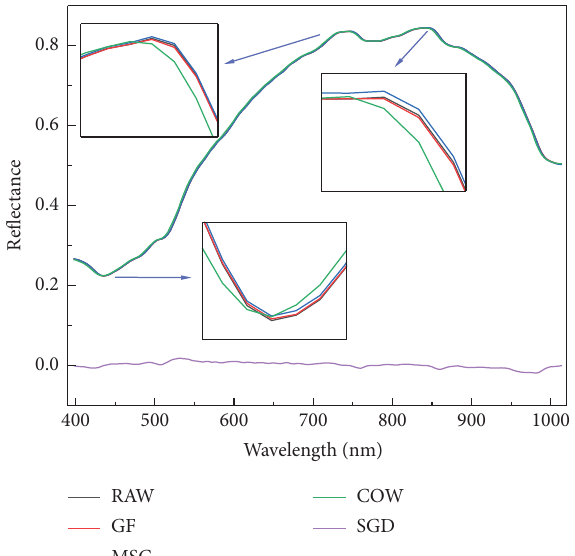
Figure 4: Curves of raw and pretreated R spectra.